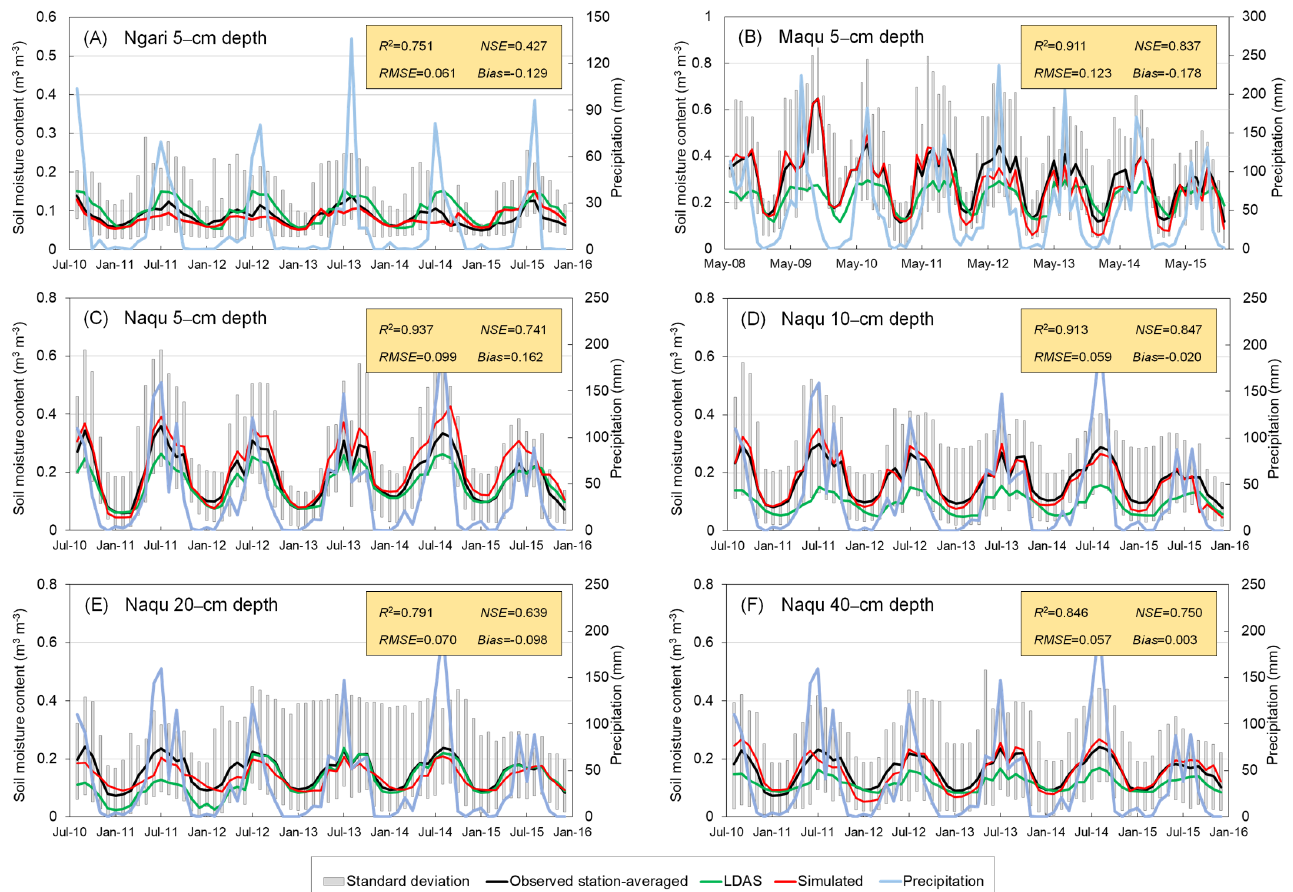
Figure 2. Temporal variability of observed station-averaged soil moisture and its standard deviation, LDAS–derived soil moisture, and reconstructed soil moisture at ( A ) 5–cm depth in the Ngari network; ( B ) 5–cm depth in the Maqu network; ( C ) 5–cm depth in the Naqu network; ( D ) 10–cm depth in the Naqu network; ( E ) 20–cm depth in the Naqu network; ( F ) 40–cm depth in the Naqu network.